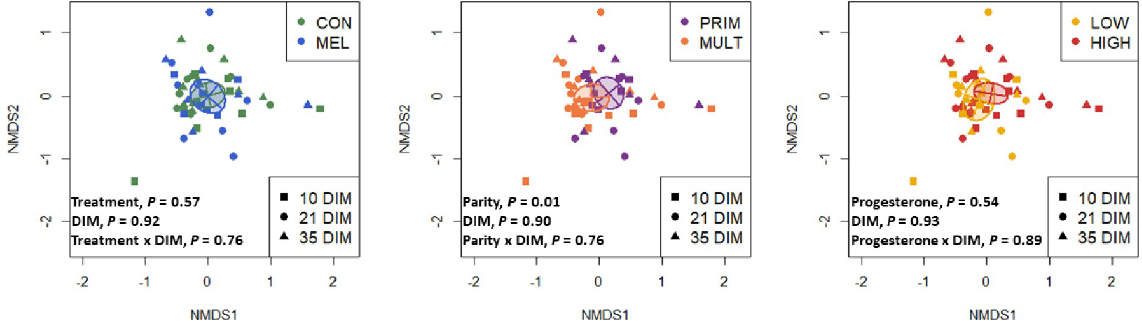
Fig 3. Effects of meloxicam treatment (n = 9, control (CON) and n = 7, meloxicam (MEL)), parity (n = 7, primiparous (PRIM) and n = 9, multiparous (MULT)), and blood progesterone concentration at 35 DIM (n = 10, > 1 ng/mL (HIGH) and n = 6, � 1 ng/mL (LOW)) on the dynamics of the uterine microbiota of clinically healthy postpartum dairy cows (n = 16) in samples collected at 10, 21, and 35 d in milk (DIM). Principal coordinate analysis for Bray-Curtis dissimilarity (genus level) was not affected by MEL or progesterone concentration at 35 DIM. Genera beta diversity (Bray-Curtis dissimilarity) showed differences in microbiome composition between parity groups (analyzed via PERMANOVA with 1000 permutations).